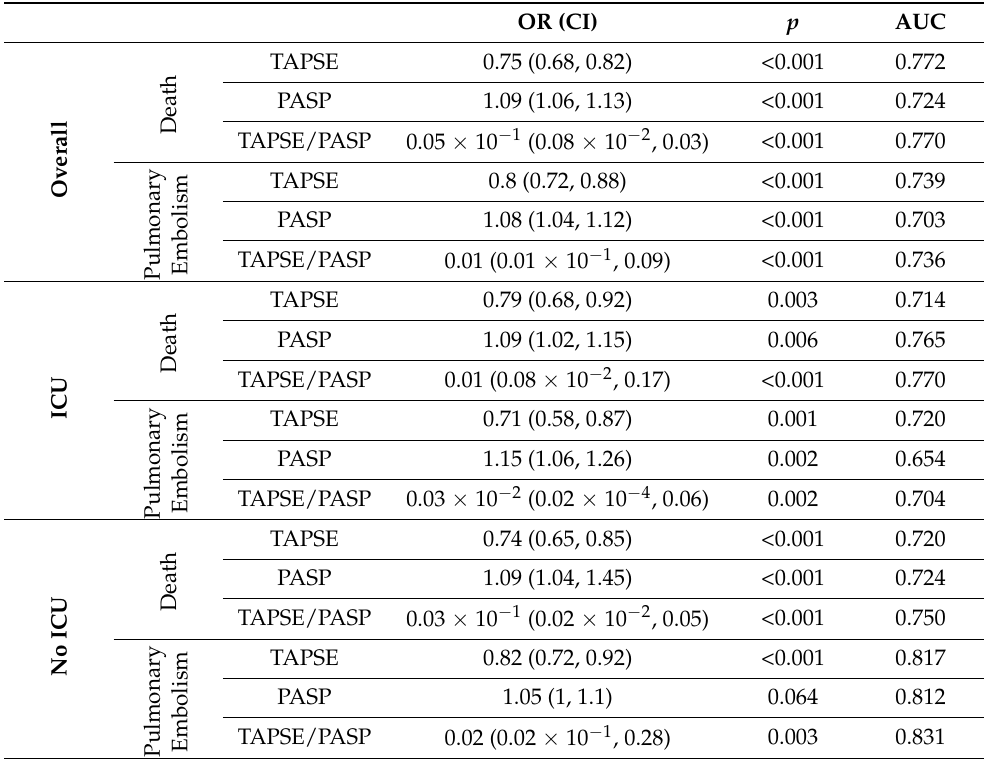
Table 2. Univariable logistic regression analysis.